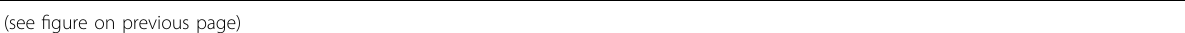
Fig. 3 High-throughput phenotypic assay using human iPSC-derived neurons for modulators of CRMP2 phosphorylation. a High- throughput assay procedures, in which expanded NPCs were induced into postmitotic differentiation by growth factor withdrawal in fl asks, maintained with periodic media change for 3 weeks, at which time the neuronal culture was dissociated, re-plated to 96-well plates, and matured for another week before small molecule compound treatment for 24-h followed by fi xation, immuno fl uorescence staining, and detection of p- CRMP2 T514 signal intensity using laser-scanning cytometry (Acumen eX3) or automated confocal microscopy for image acquisition followed by subsequent image analysis. b Human neuronal cultures immunostained for nuclei, MAP2 and p-CRMP2 T514 . Postmitotic neurons differentiated from hiPSC-derived NPCs for four weeks were seeded in 96-well plates for treatments and immunocytochemistry. c Representative images of CHIR-99021 treatment on p-CRMP2 T514 intensity (green) versus MAP2 intensity (red). Intensity of p-CRMP2 T514 decreases when CHIR-99021 concentration increases. d p-CRMP2 T514 -reducing activities from existing GSK3 inhibitors shown by heatmap and quanti fi cation of p-CRMP2 T514 levels. Dose- dependent activities correspond well to their GSK3 inhibitory activities. e Quanti fi cation of p-CRMP2 T514 levels for the GSK3 inhibitor JB1121( rac ) and its enantiomers. JB1121( ent-2 ) but not JB1121( ent-1 ) showed dose-dependent effects. f Dose-dependent effect of lithium reducing p-CRMP2 T514 detected in the human neuronal assay. Relative p-CRMP2 T514 intensity level was reported as the percentage of the intensity for DMSO-treated